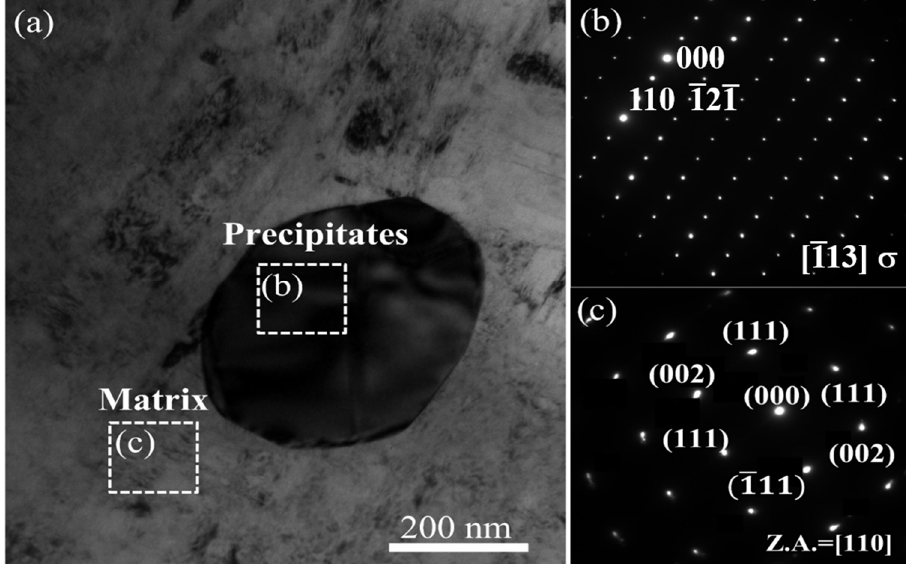
Figure 3. The bright-field TEM image of annealed Fe 50 Mn 20 Cr 20 Ni 10 MEA at 1273 K for 1 h. ( b , c ) SAED patterns of the precipitate and matrix (marked by white dotted box) in ( a ), respectively.